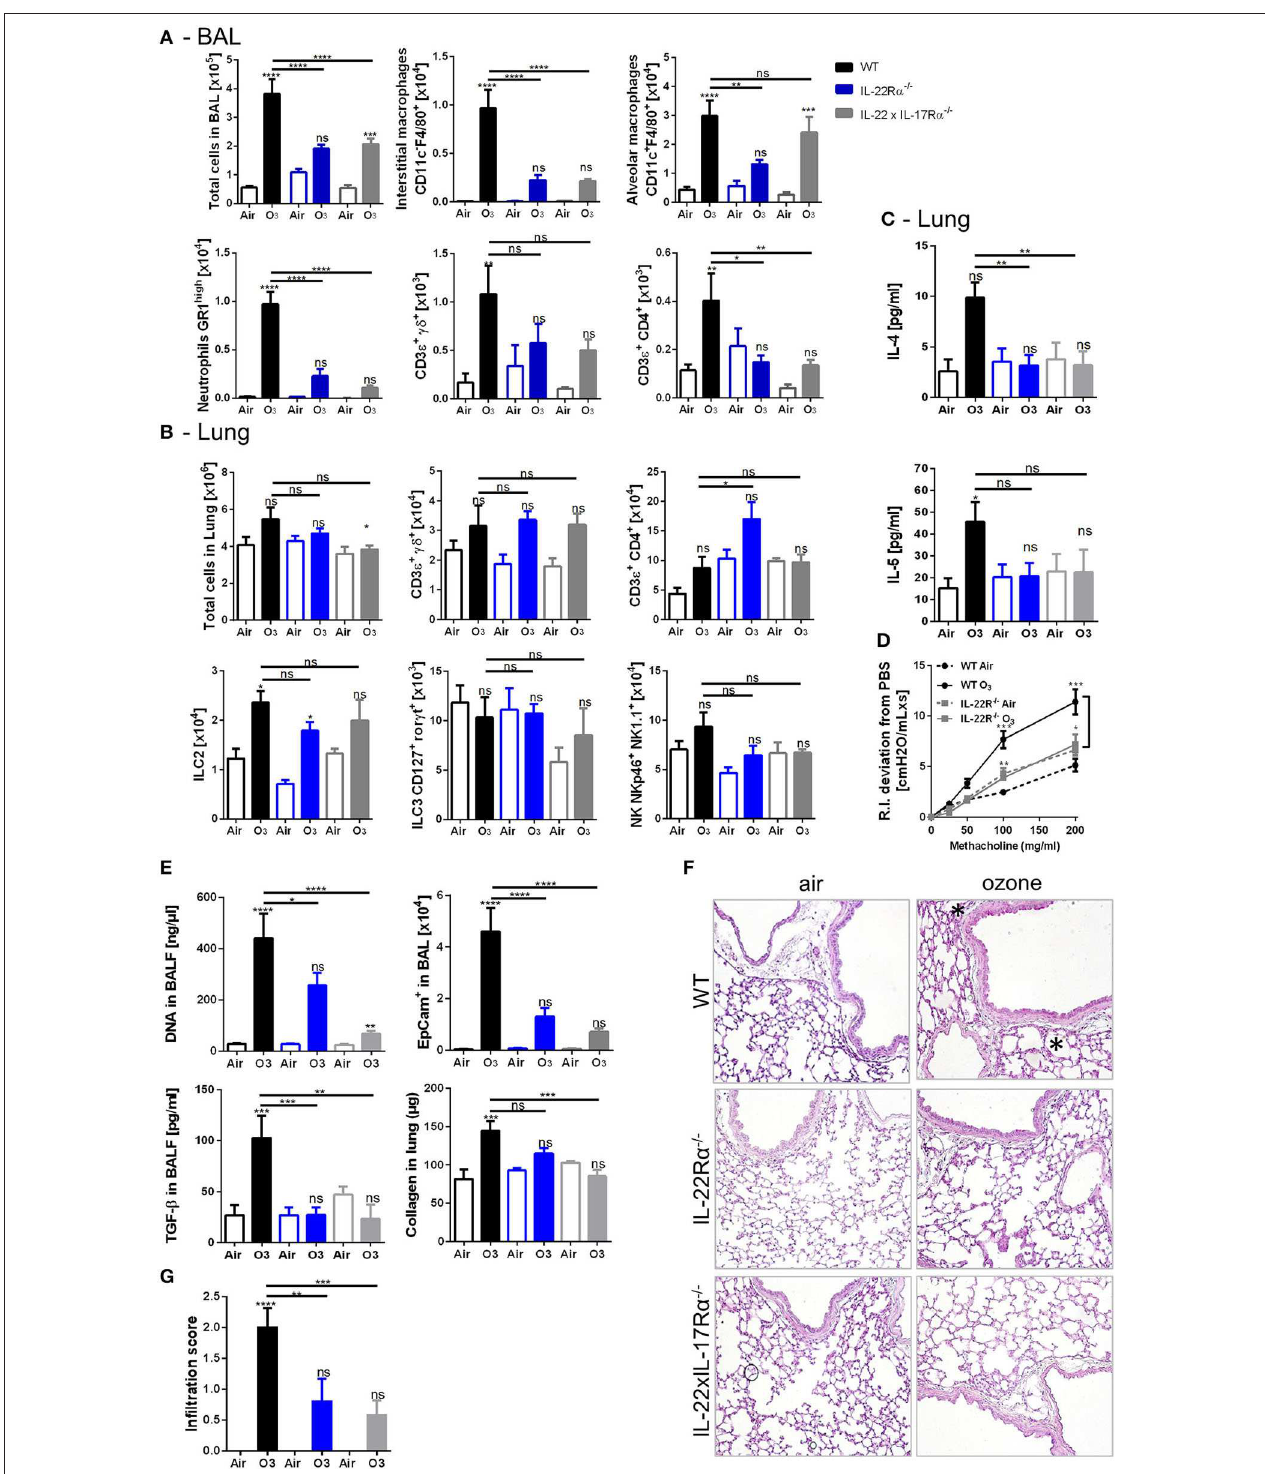
FIGURE 5 | Inflammatory parameters in IL-22R and IL-22/17R α deficient mice. BAL cells recruitment (total cells, macrophages, neutrophils, and T cells) (A) . Lung cell recruitment (total cells, neutrophils, macrophages, ILC2, ILC3, αβ , and γδ T cells) (B) , T H 2 cytokines (IL-4, IL-5) (C) , AHR (D) , and remodeling parameters (epithelial cells, DNA and TGF- β in BAL; collagen in lung) (E) ; lung histology (400 × magnification, asterisk show cell infiltration) (F) and cell infiltration score (G) after ozone exposure in WT and AhR-deficient mice. The data are representative of one from two independent experiments with n = 5–6 mice per group. Values are expressed as mean ±